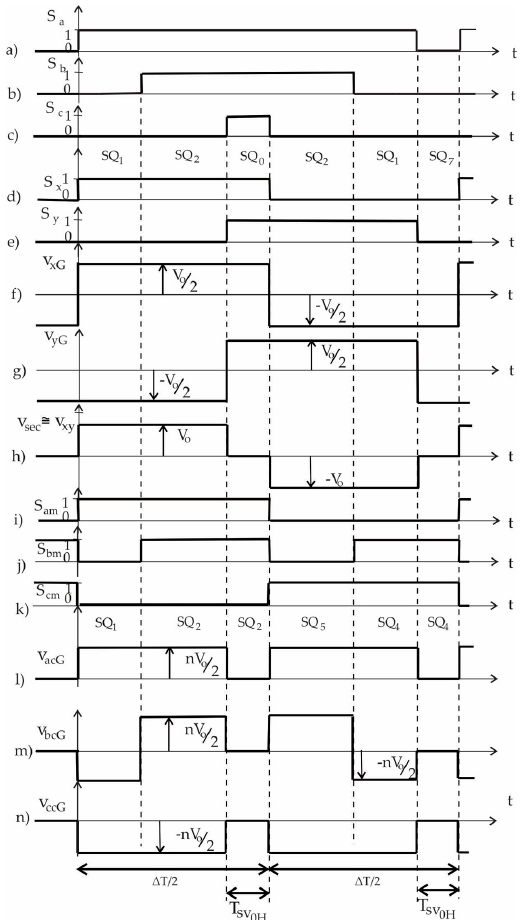
Figure 2. Derivation of the transistor switching states of the modular active rectifier of Figure 1b together with their voltage converter waveforms: ( a ) switching state S a ; ( b ) switching state S b ; ( c ) switching state S c ; ( d ) switching state S x ; ( e ) switching state S y ; ( f ) voltage v xG ; ( g ) voltage v yG ; ( h ) voltage v sec ; ( i ) switching state S am ; ( j ) switching state S bm ; ( k ) switching state S cm ; ( l ) voltage v acG ; ( m ) voltage v bcG ; ( n ) voltage v ccG .